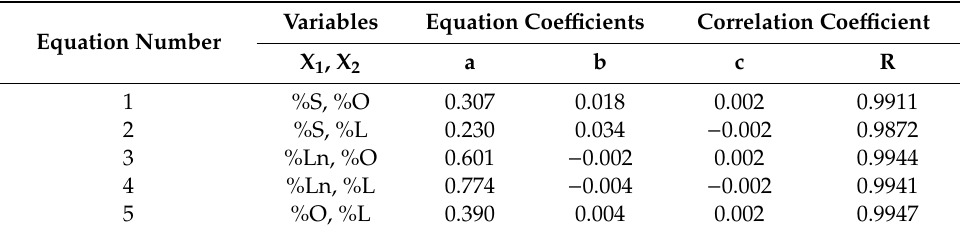
Table 3. Coe ffi cients of the equations B OMC = a + b X 1 + c X 2 that relate the in vitro bioaccessibility of the oil main components (B OMC ) and the molar percentage of certain acyl groups saturated (%S), oleic (%O), linoleic (%L) or linolenic (%Ln) in the oil before digestion, together with their correlation coe ffi cients